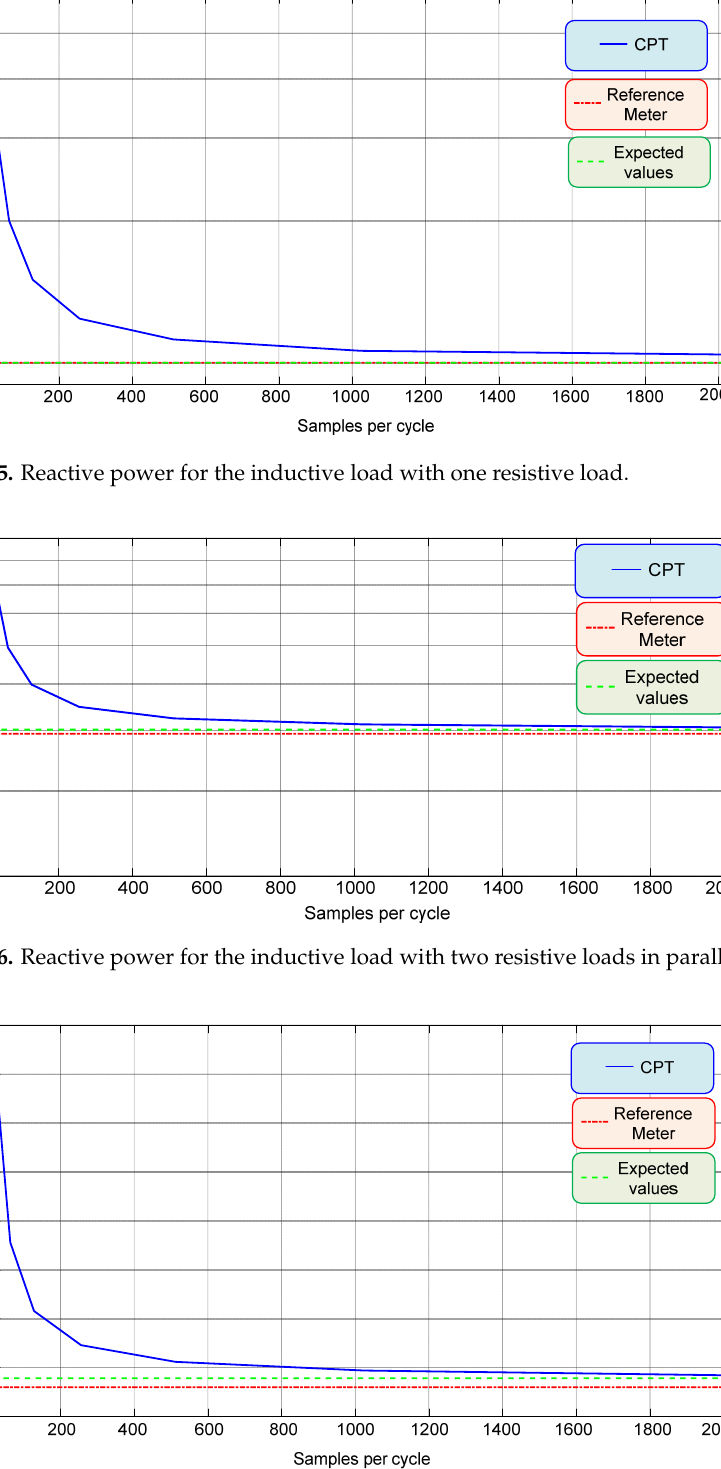
Figure 7. Reactive power for the inductive load with three resistive loads in parallel.